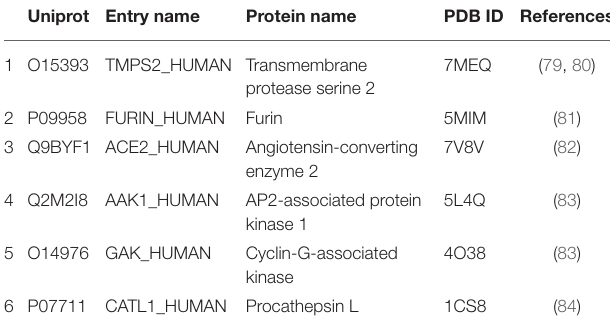
TABLE 3 | Key host-target proteins in COVID-19.